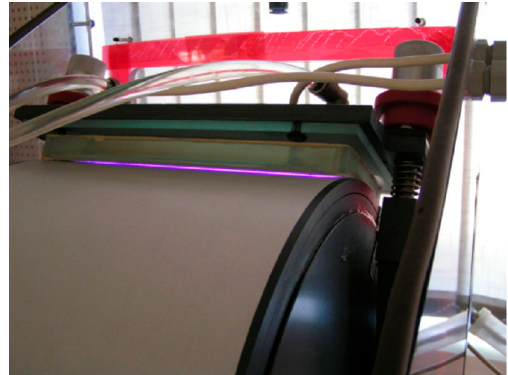
Figure 1. Photo of a closer view of the plasma reactor with a concavely curved diffuse coplanar surface barrier discharge (DCSBD) electrode with the electrode gap of 0.3 mm [17].